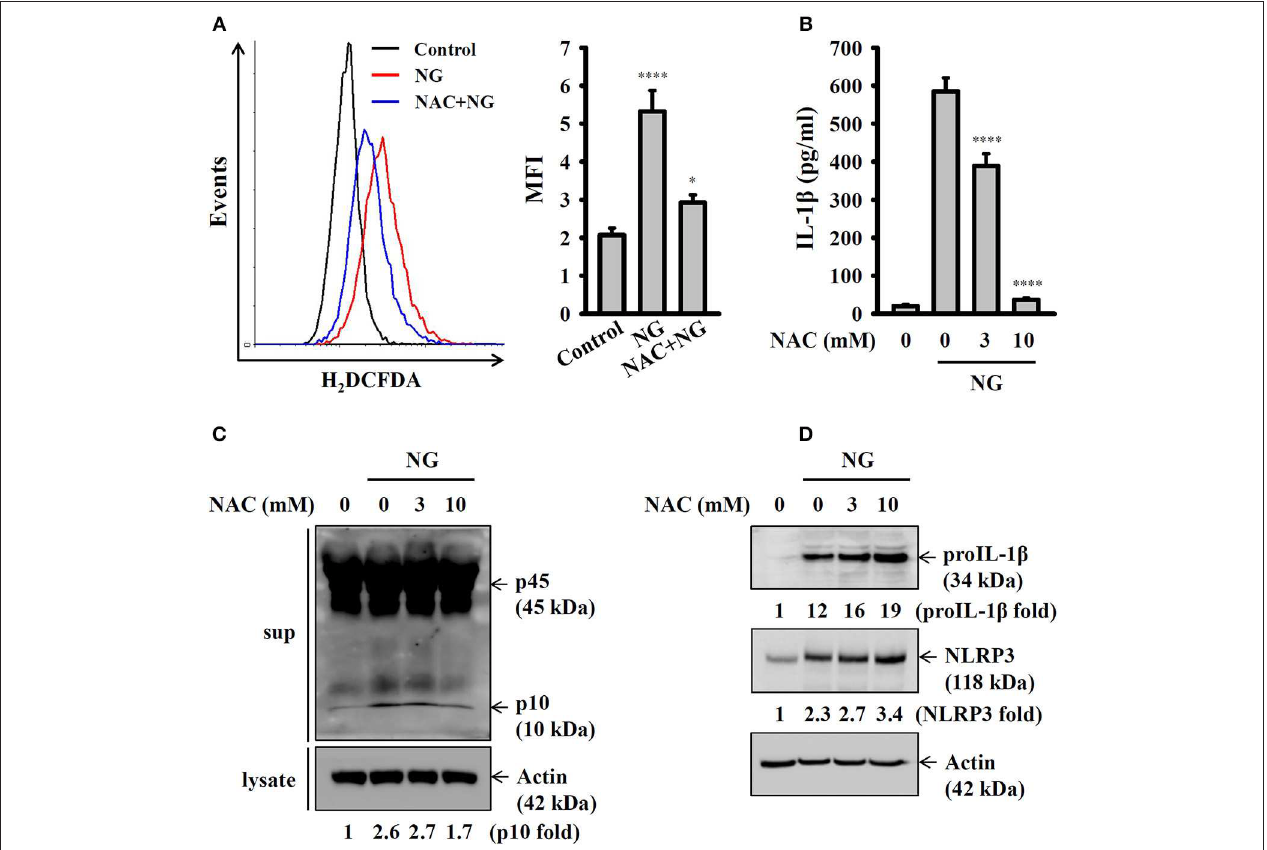
FIGURE 6 | Activation of the NLRP3 inflammasome by NG through ROS-dependent pathways. (A) J774A.1 macrophages were incubated for 0.5h with 10mM of NAC, followed by infection for 4h with NG at 50 MOI. The levels of ROS in the cells were measured by 2 ′ ,7 ′ -dichlorofluorescein diacetate. (B,C) J774A.1 macrophages were incubated for 0.5h with NAC, followed by infection for 24h with NG at 50 MOI. The levels of IL-1 β in the supernatants were measured by ELISA (B) , and the levels of p45/p10 in the supernatants were measured by Western blotting analysis (C) . (D) J774A.1 macrophages were incubated for 0.5h with NAC, followed by infection for 8h with NG at 50 MOI. The levels of proIL-1 β and NLRP3 in the cell lysates were measured by Western blotting analysis. The ROS and ELISA data are expressed as the mean ± SD of three separate experiments. The Western blotting results are representative of three different experiments, and the band intensity was analyzed by ImageJ and expressed as the fold change compared with the mock control group normalized to actin. A significant difference at the level of * p < 0.05 and **** p < 0.0001, respectively, compared to untreated control cells (A) or NG-infected cells (B) (One-way ANOVA with Dunnett’s multiple comparisons